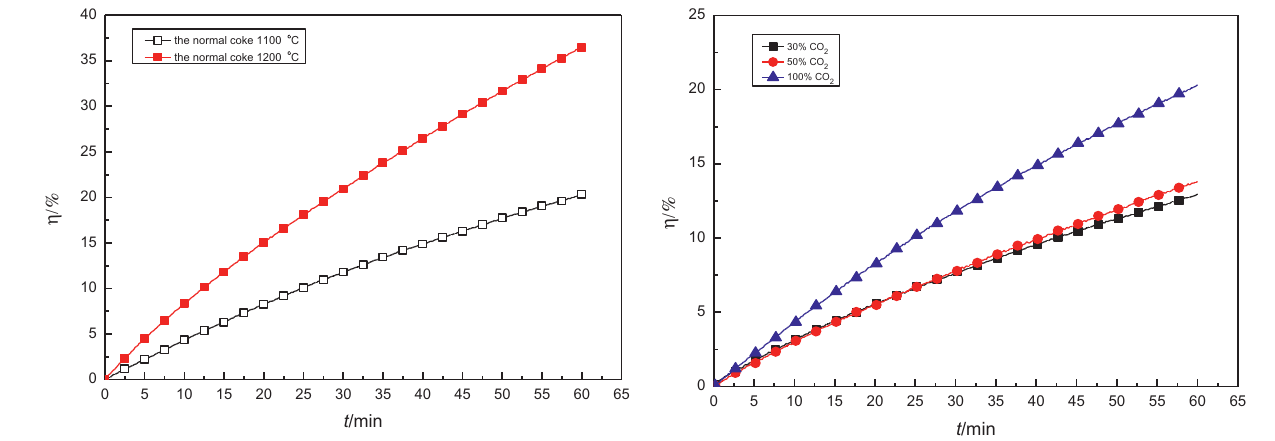
Figure 2: Weight loss of the normal coke at various temperatures.